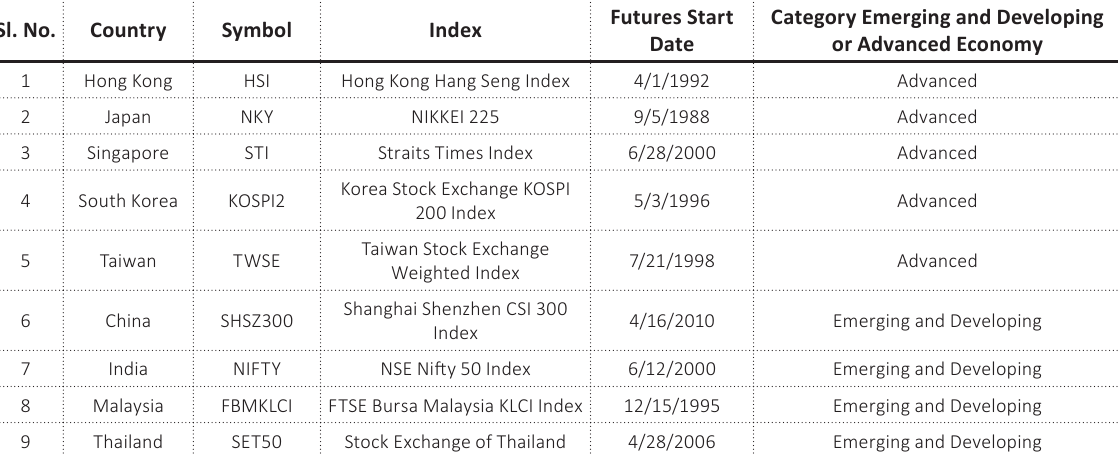
Source: http://www.imf.org./external/pubs/ft/weo/2020/01/weodata/groups.htm